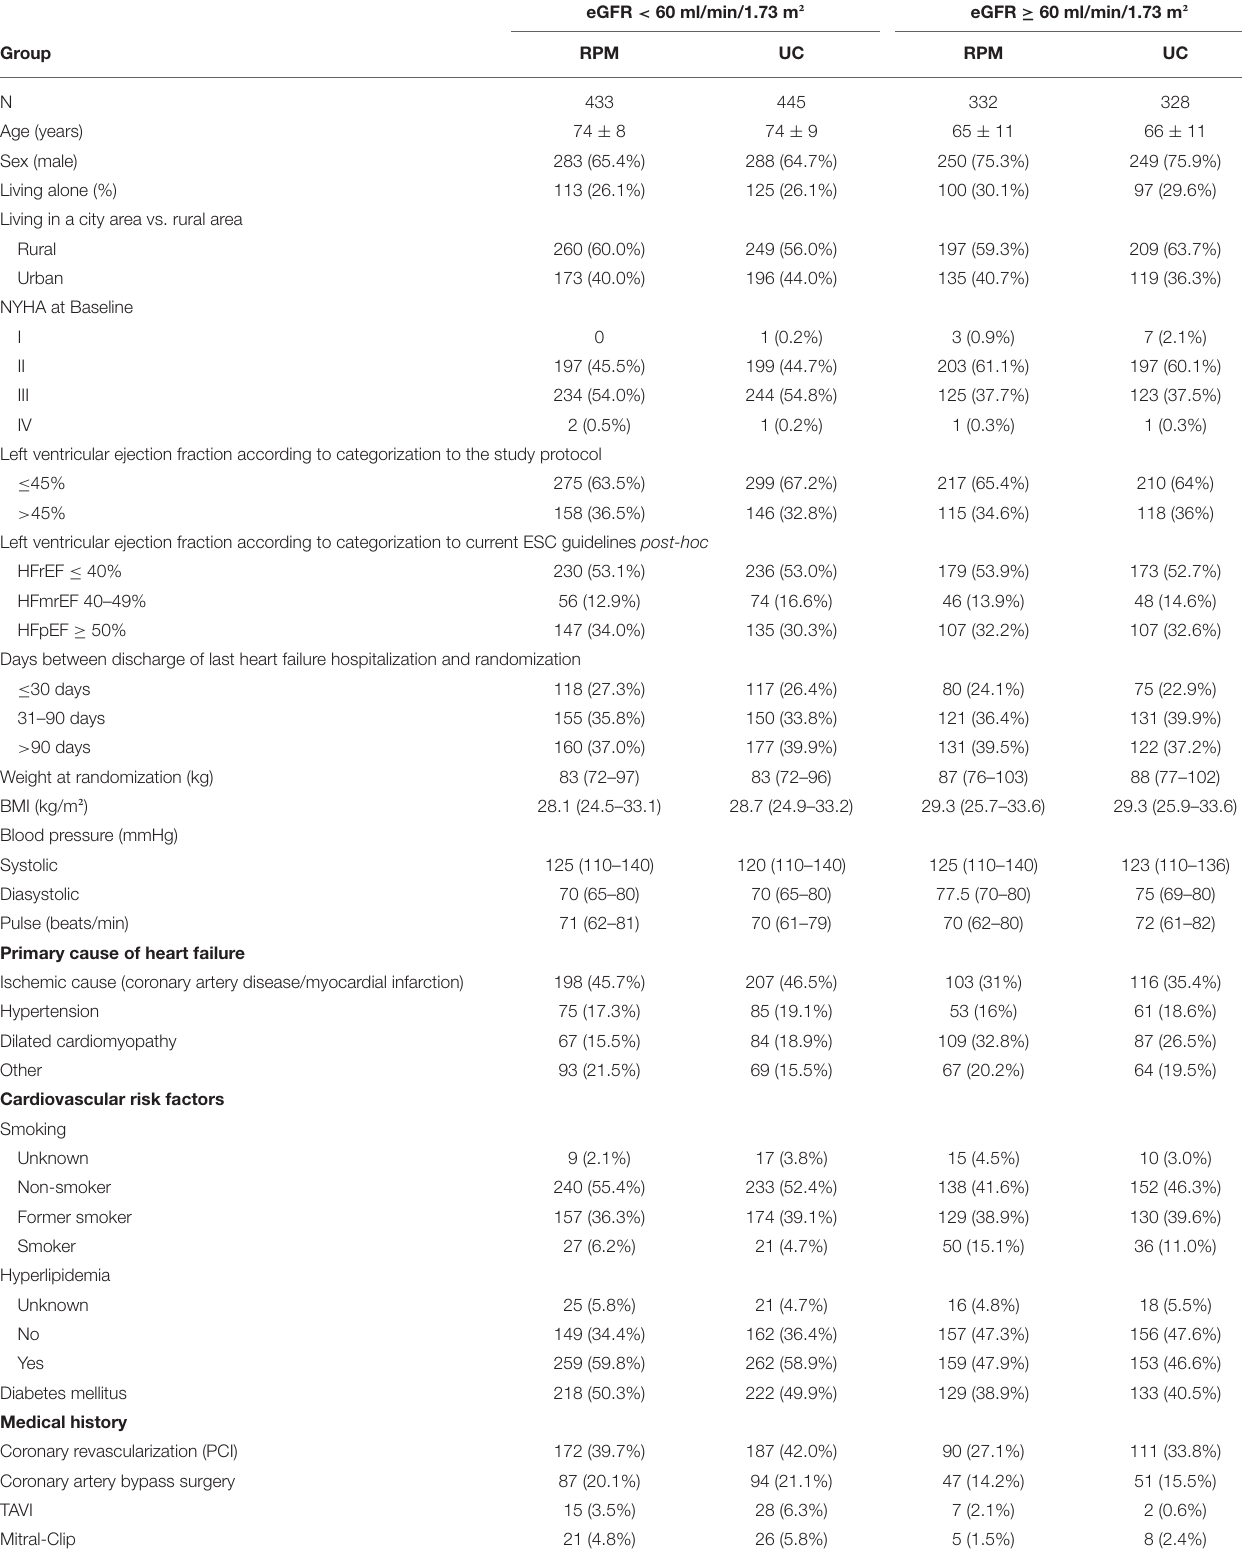
TABLE 1 | Demographics of remote patient management (RPM) and control group (UC) with regard to eGFR at